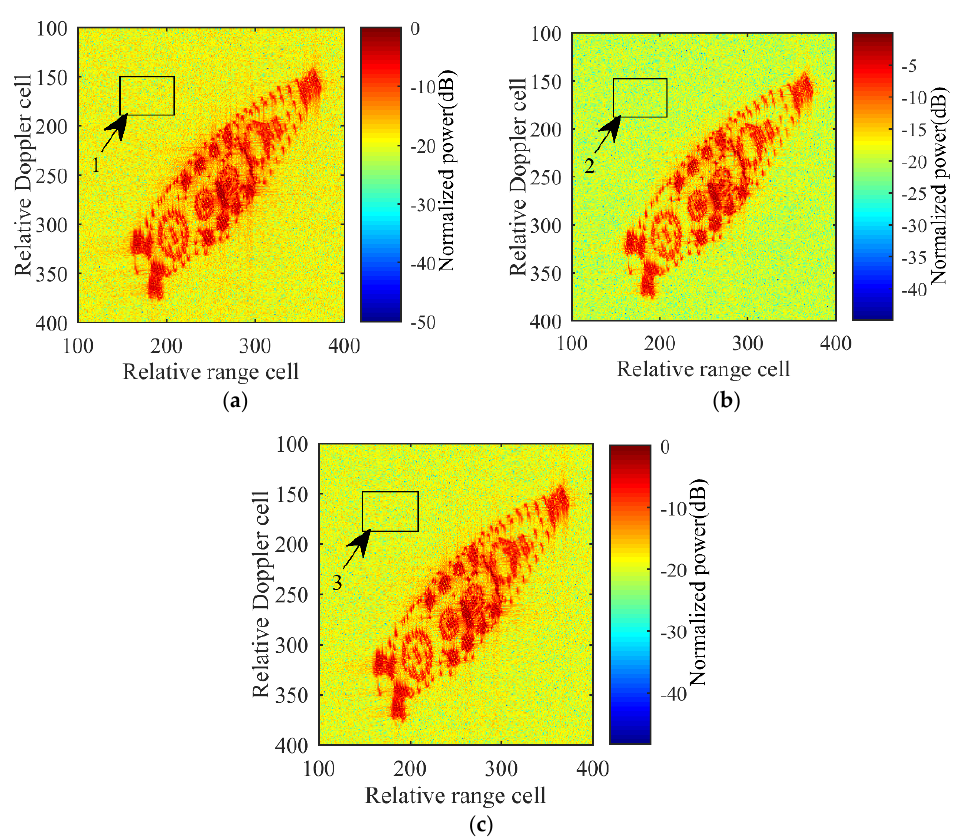
Figure 13. ISAR imaging results. ( a ) AV-Channel. ( b ) AC-Channel. ( c ) AH-Channel.